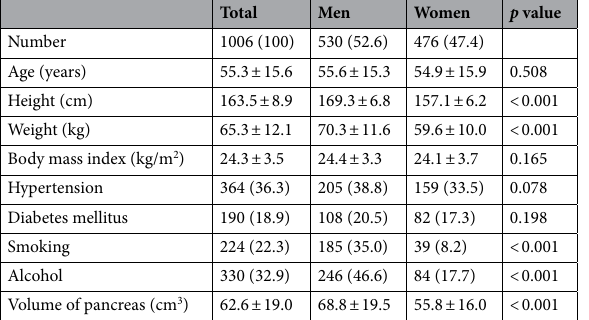
Table 1. Demographics of participants. Values are expressed as n (%) or mean ± standard deviation, unless otherwise indicated.